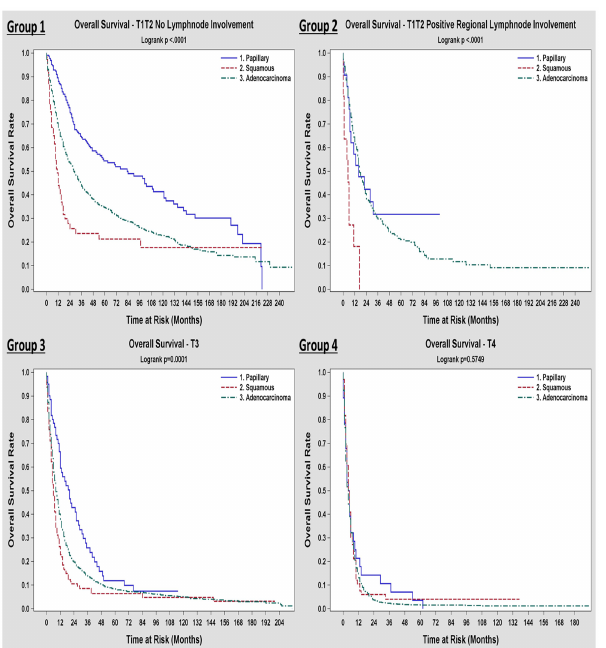
Fig 2. Kaplan-Meier overall survival curves among the three histologic types of gallbladder carcinoma based on the American Joint Committee on cancer staging groups [31].